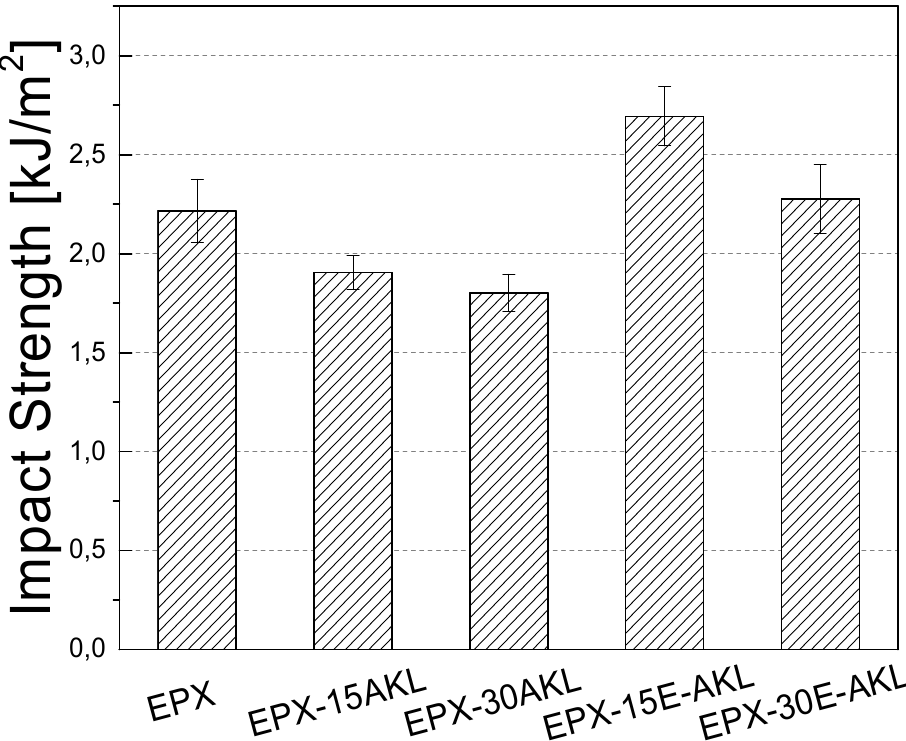
Figure 9. Impact strength of pristine and lignin-based epoxy.